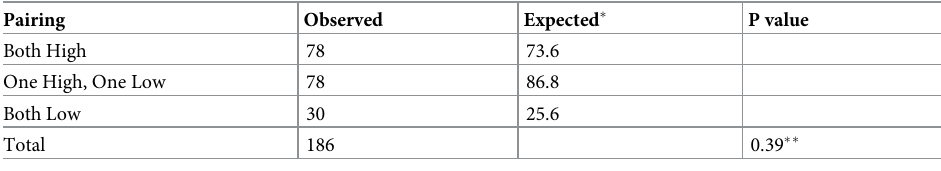
Table 1. Paired student grades for the medicine sub-internship. Pairing